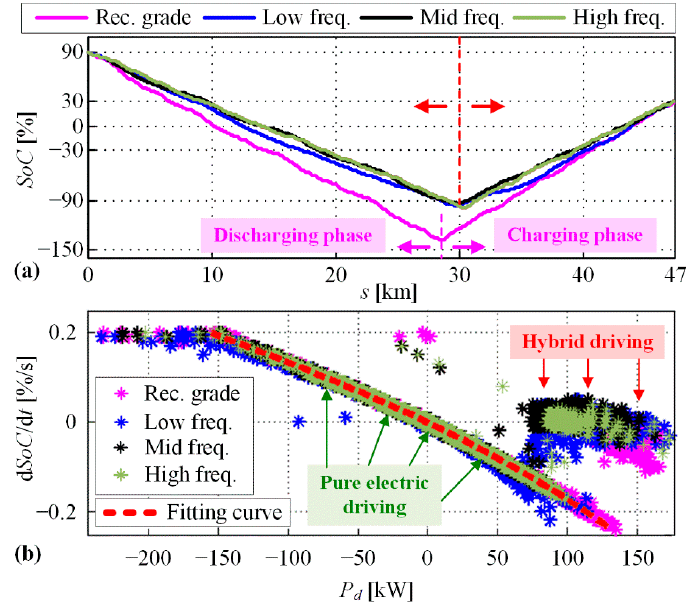
Figure 11. ( a ) Optimal SoC trajectories from Figure 10 decomposed and rearranged to battery discharging (i.e., P batt > 0, dSoC / dt < 0) and charging sections (i.e., P batt < 0, dSoC / dt > 0) and ( b ) SoC time derivative with respect to power demand P d .